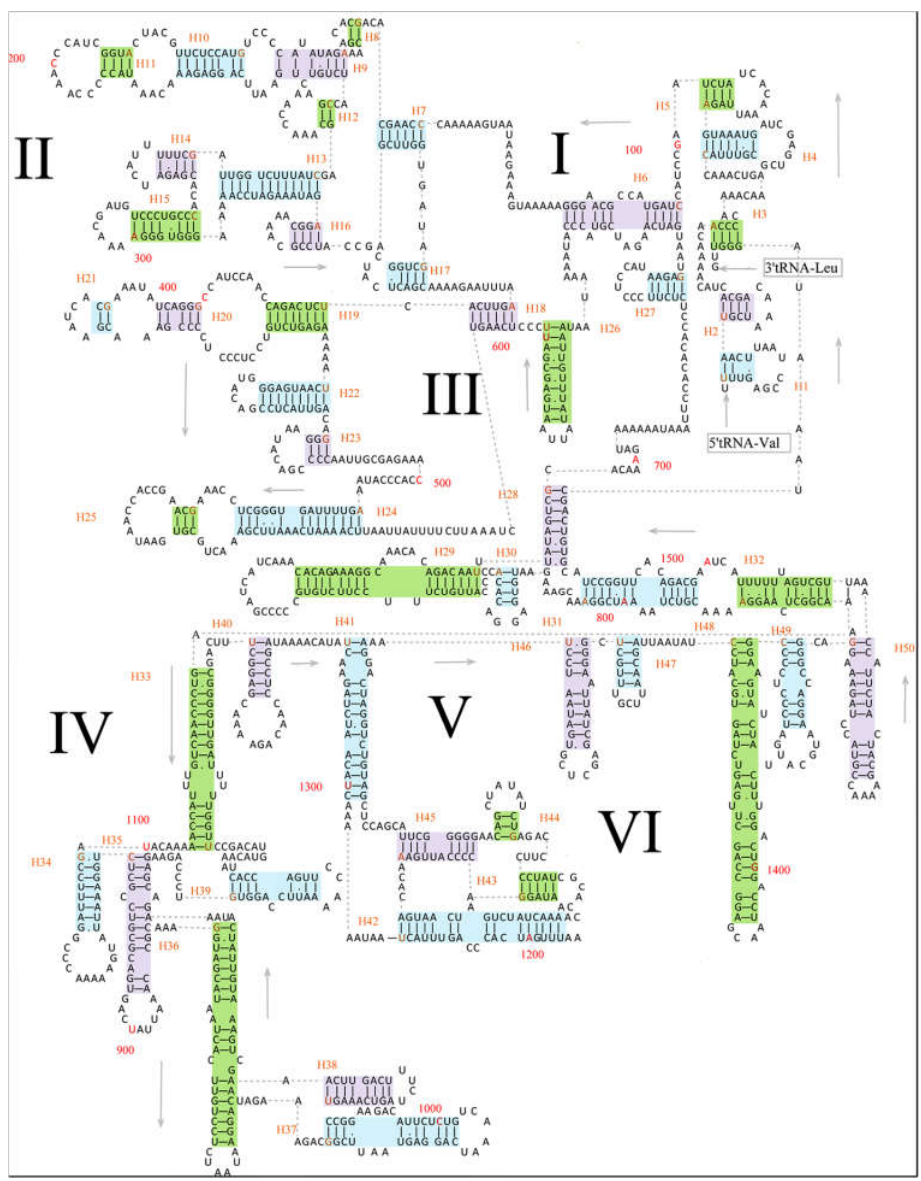
Figure 4. Predicted secondary structure of the 16S rRNA in E. scripta KZL15. Watson-Crick base pairings are indicated by the dashes (–); G–U bases pairings are indicated by dots (•). The numbering of helix follows Hickson et al. [45]. Roman numerals indicate the conserved domain structures; I–VI indicate six domains in the secondary structure of 16S rRNA. Every 100th base is marked in red. Helices were marked with green, purple, and blue. The number of helices and the first base of helix were marked in orange; H means helix. Generated using RNAfold [43] and edited using Microsoft PowerPoint (14.0.4760.1000)